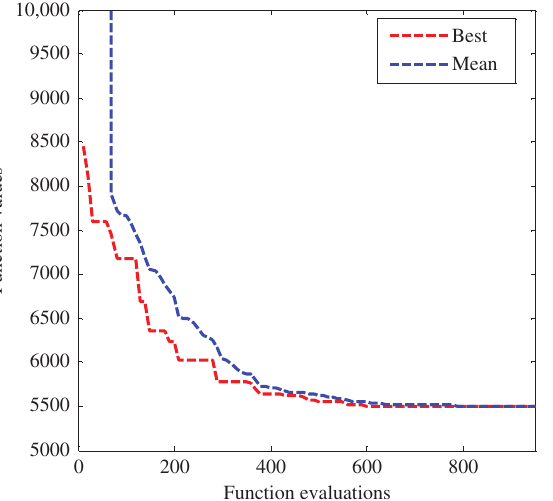
Figure 7: Convergence of Best and Mean Values of Objective Function for Planar 10-Bar Planar Truss.